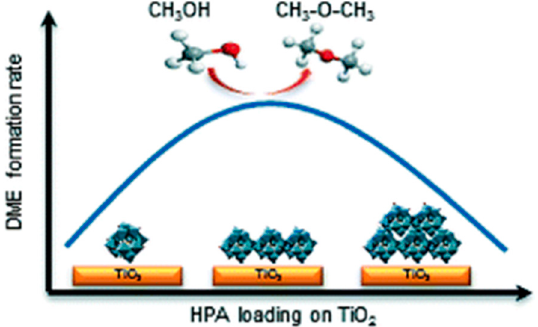
Figure 11. Influence of heteropoly acids (HPAs) loading on TiO 2 on the DME formation rate (adapted from [118] with permission from RSC License No 1099726).